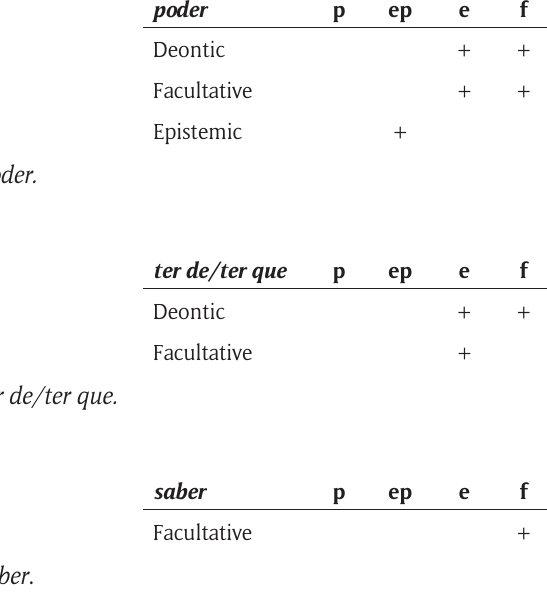
Table 5: Uses of poder.